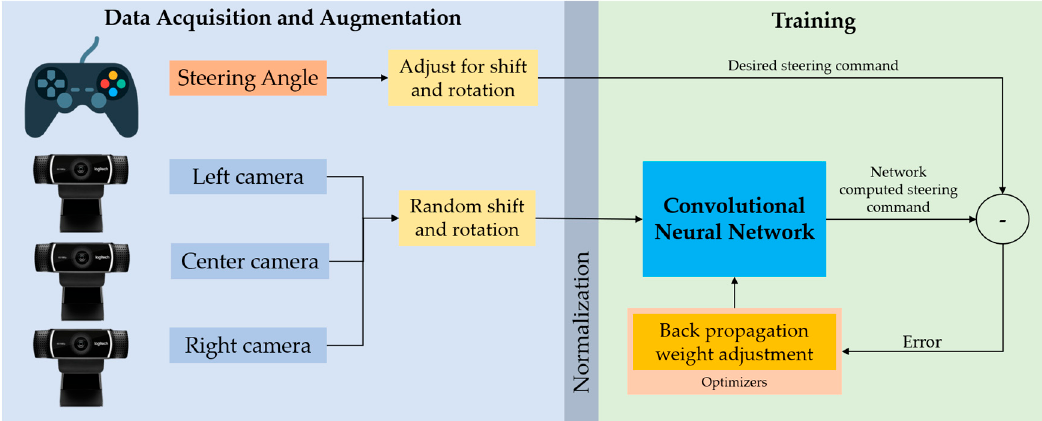
Figure 11. Diagram for the data acquisition and training of the neural network.